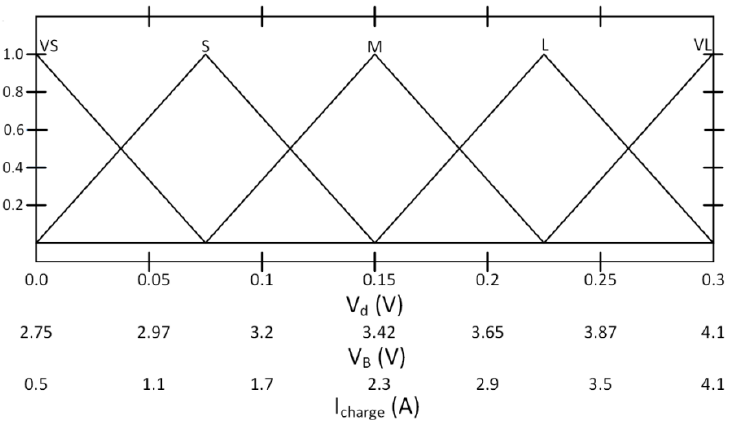
Figure 3. Membership function for a fuzzy controller.